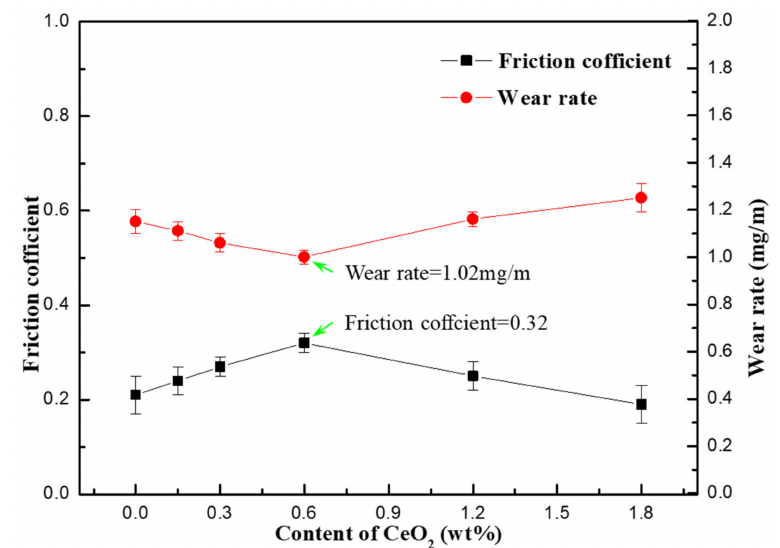
Figure 8. The curves of the friction coe ffi cient and wear rate of SiCp / Al-Si composite with di ff erent CeO 2 contents.